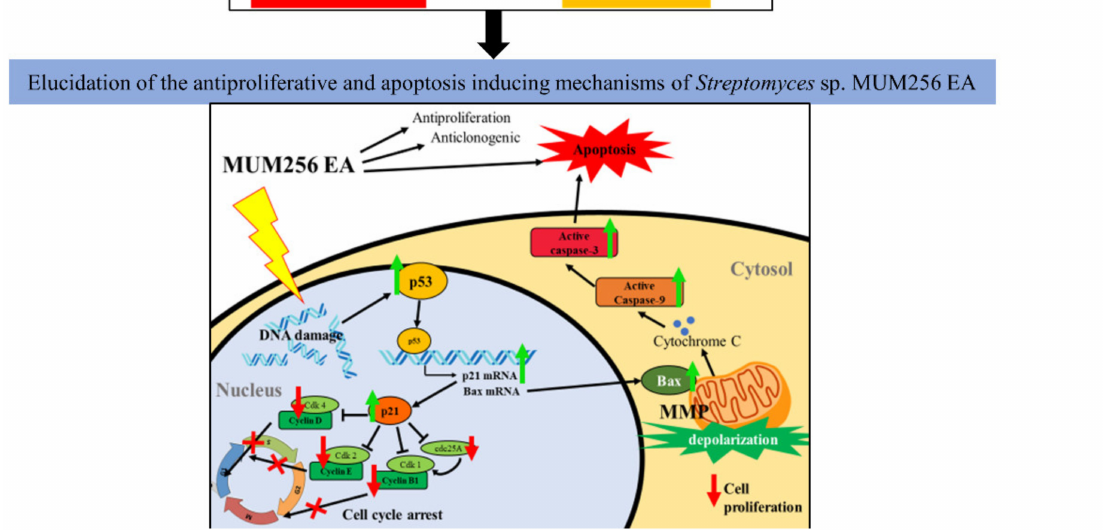
Figure 1. The summarized flow chart of this study. The figure illustrates the fermentation, crude extract extraction, fractionation and elucidated mechanisms of MUM256 EA in cell-cycle arrest and apoptosis